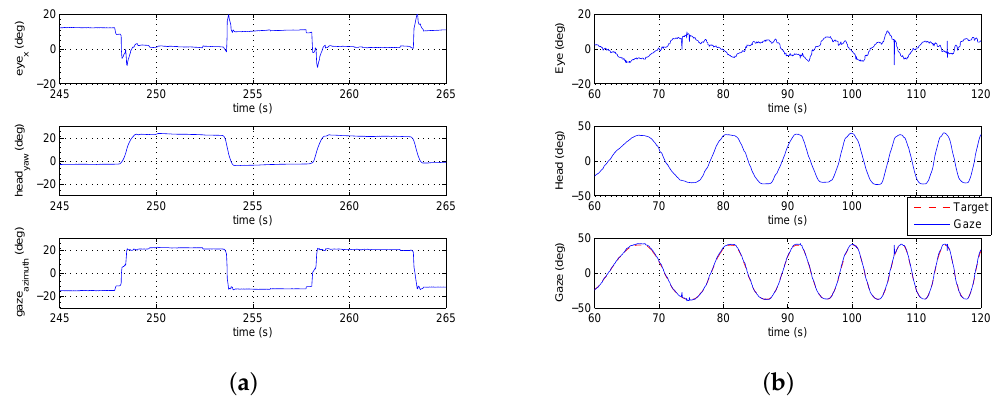
Figure 22. Experiments for saccades and smooth pursuit gaze tracking. ( a ) Head–eye-gaze time history